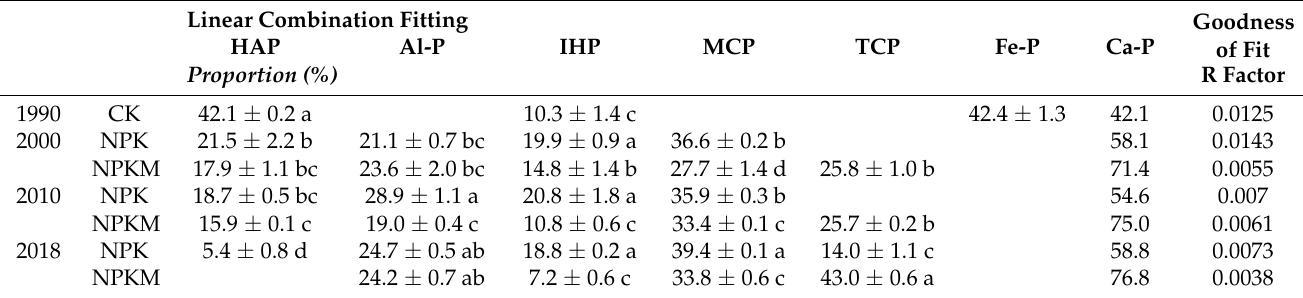
Table 2. The linear fitting of P fractions with P K-edge XANES in the studied soil under long-term field trial in Mollisol.